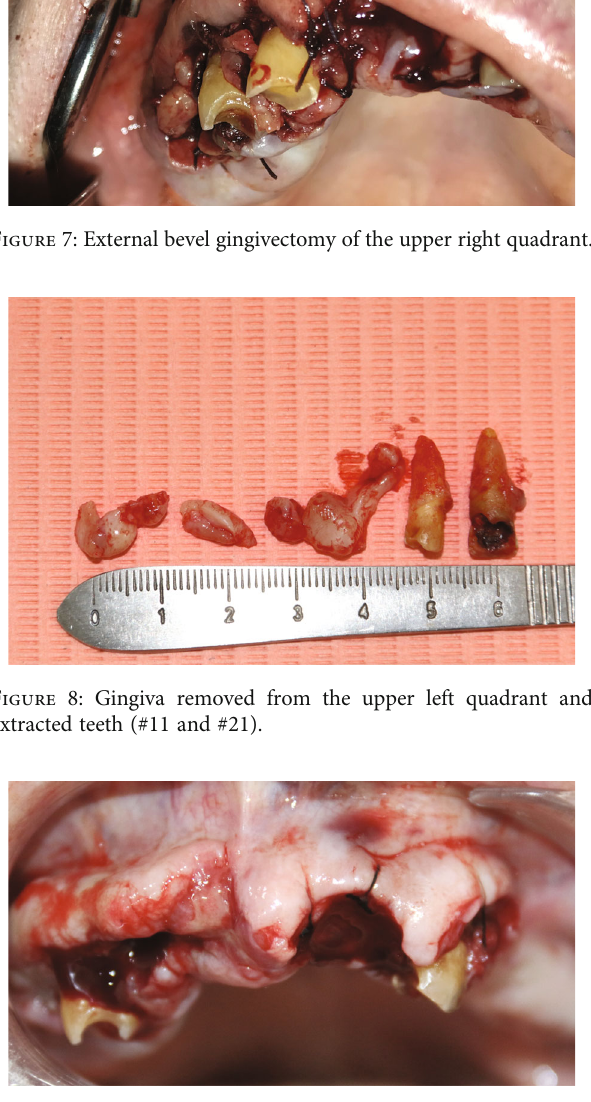
Figure 9: External bevel gingivectomy of the upper left